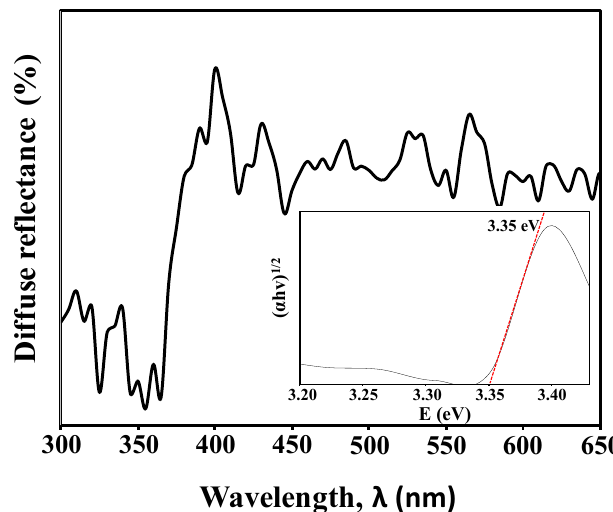
Figure 7. The UV–vis diffuse reflectance spectrum of ZnO NRs obtained at an immersion time of 2 h. Inset shows the Tauc plot of the spectrum.